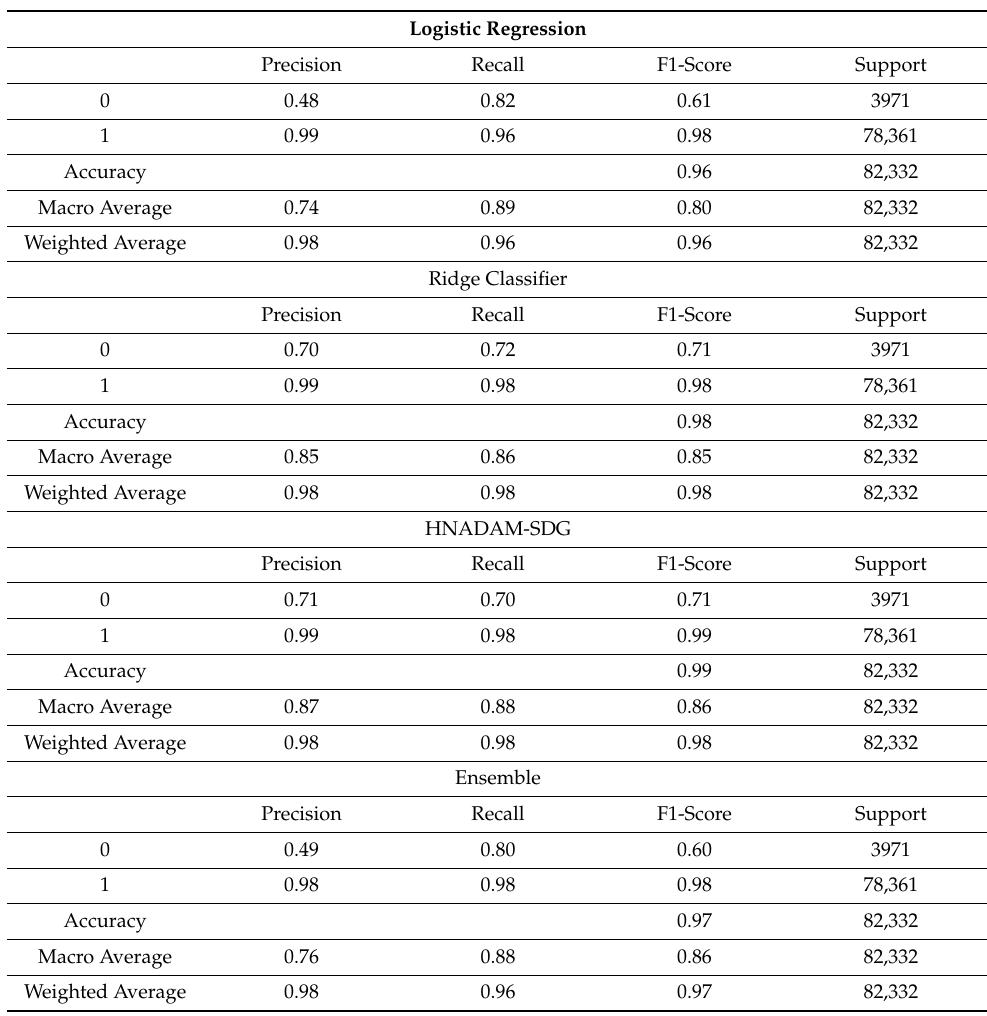
Figure 4. Binary Classification Confusion Matrix. Table 3. Performance